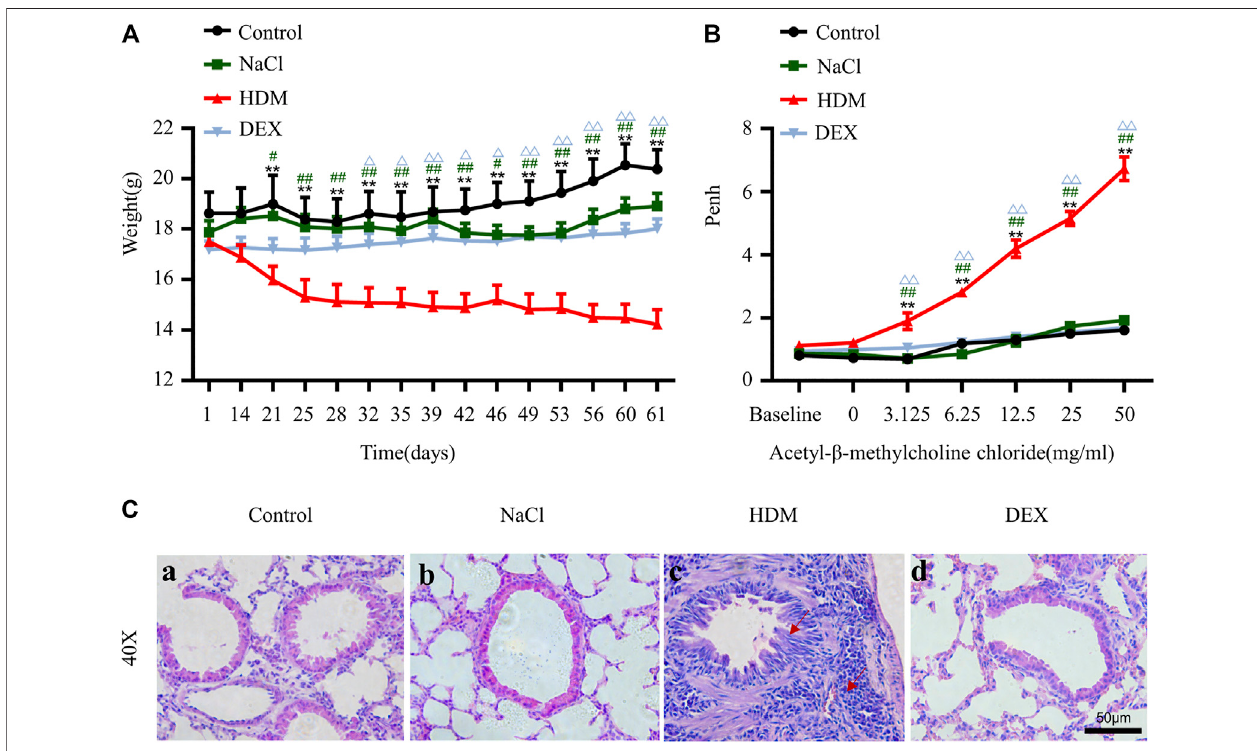
FIGURE 2 | The allergic asthma mice model was established by house dust mite (HDM). (A) Changes in body weight during the model construction cycle. (B) Detection of airway hyperresponsiveness. [C(a – d)] HE staining of lung tissue. n (cid:1) 8. * p < 0.05 and ** p < 0.01 between HDM group and Control group. # p < 0.05 and ## p < 0.01 between HDM group and NaCl group. △ p < 0.05 and △△ p < 0.01 between HDM group and DEX